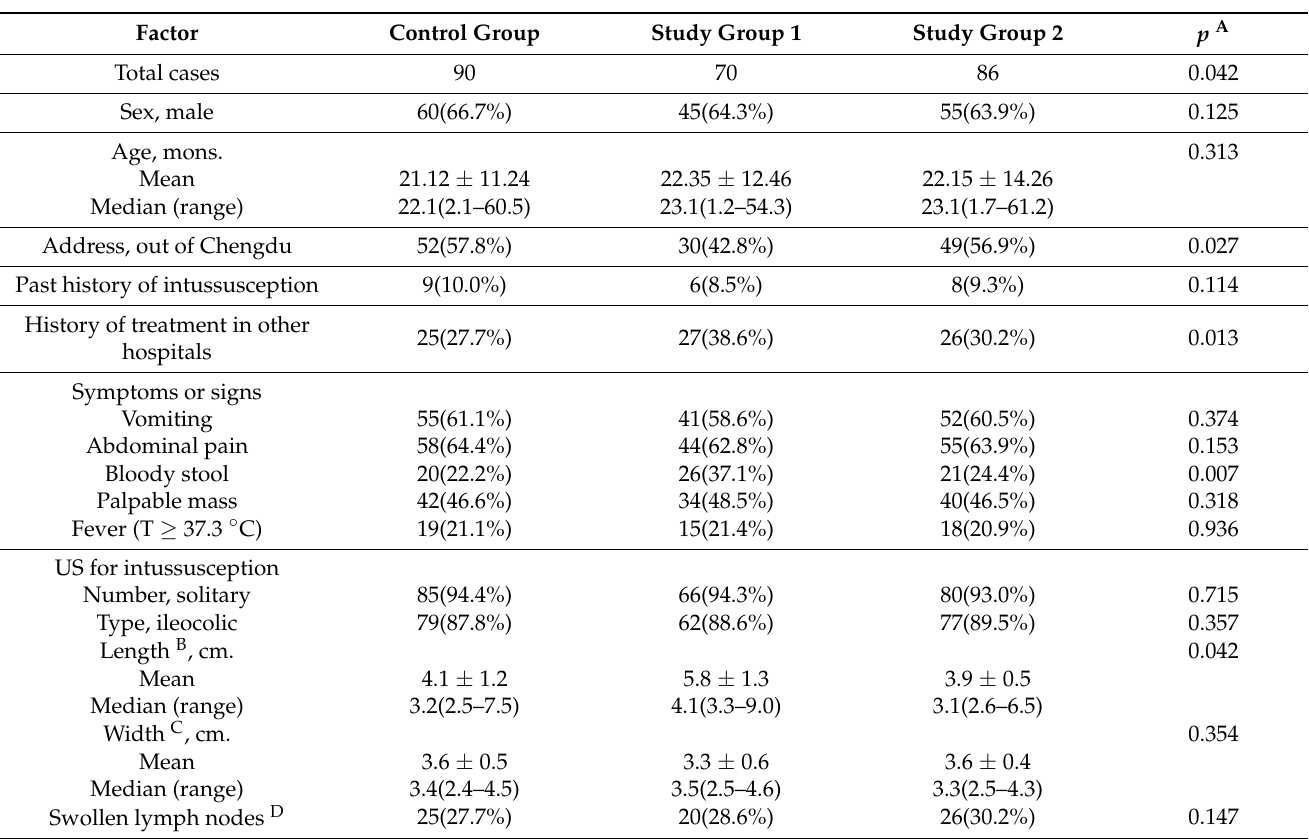
Table 1. Clinical characteristics of pediatric patients with intussusception in different periods of the COVID-19